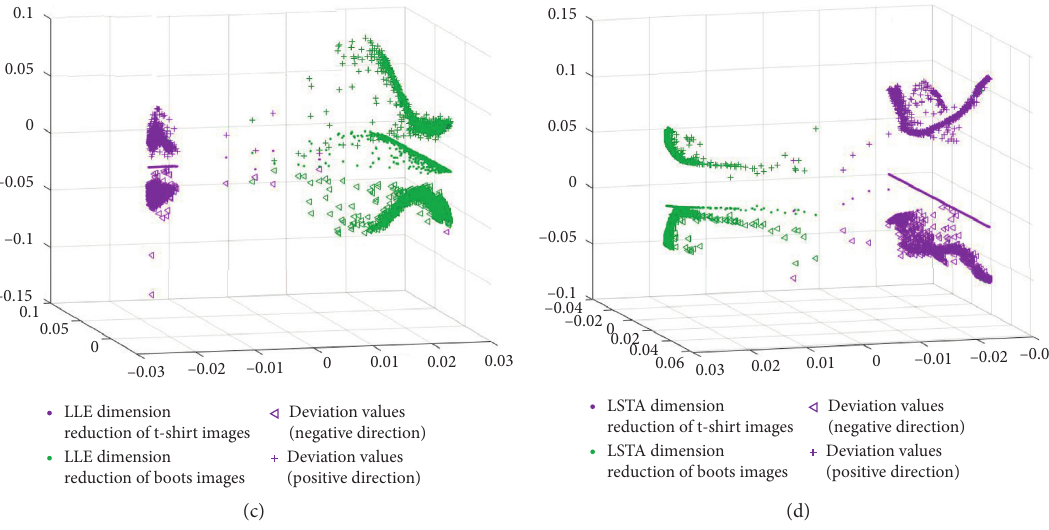
Figure 20: Manifold dimension reduction results for two-class samples and results of deviation values.